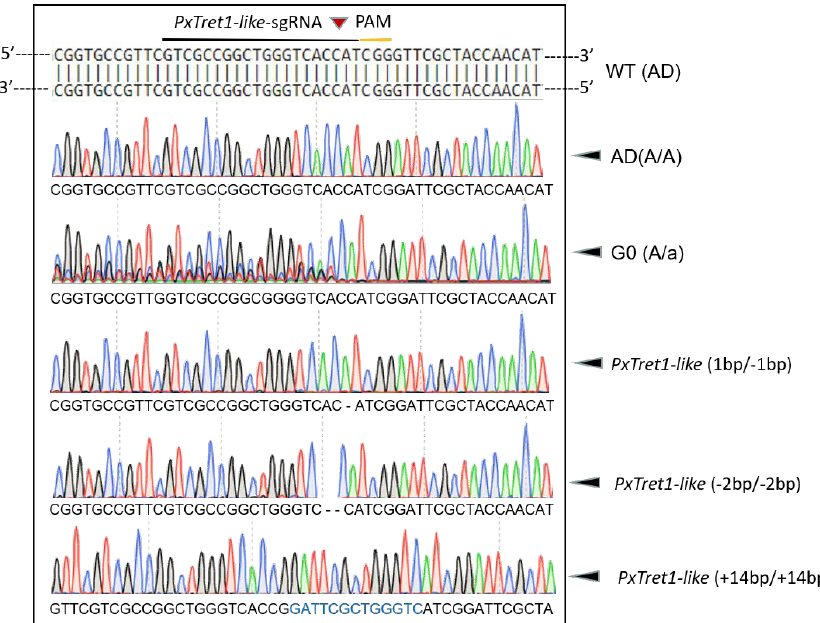
Figure 4. Targeted mutation of Plutella xylostella PxTret1-like mediated by CRISPR/Cas9. The sgRNA target sequence of PxTret1-like was identified in exon 3 and is underlined in black; the PAM se- quence adjacent to the sgRNA target sequence is also underlined in yellow; and the cleavage site is indicated with a red inverted triangle. Green peak represents A; red peak represents T; blue peak represents C; and black peak represents G. A stretch of typical multiple peaks of PCR products directing sequencing was the main characteristic of mutated G0 individuals. Deleted bases are shown as dashes, and the inserted bases are indicated in blue.